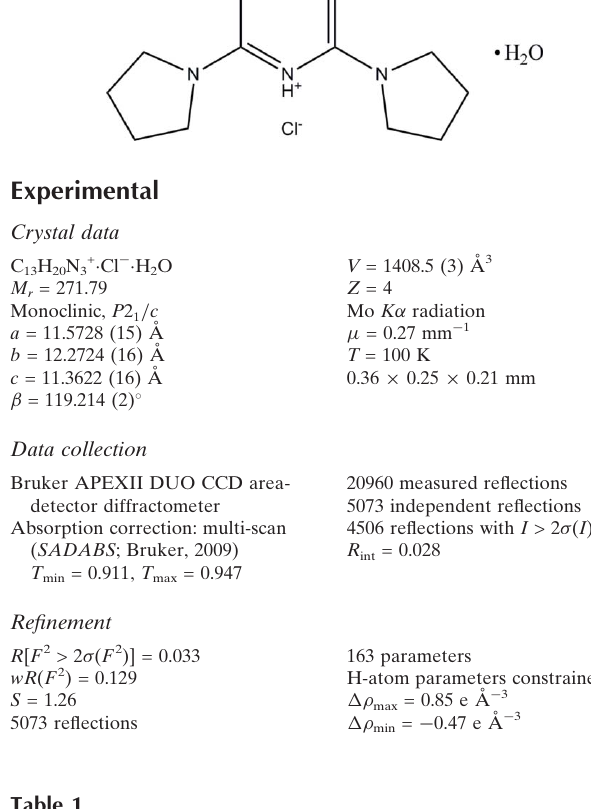
Hydrogen-bond geometry (A˚ , (cid:4)